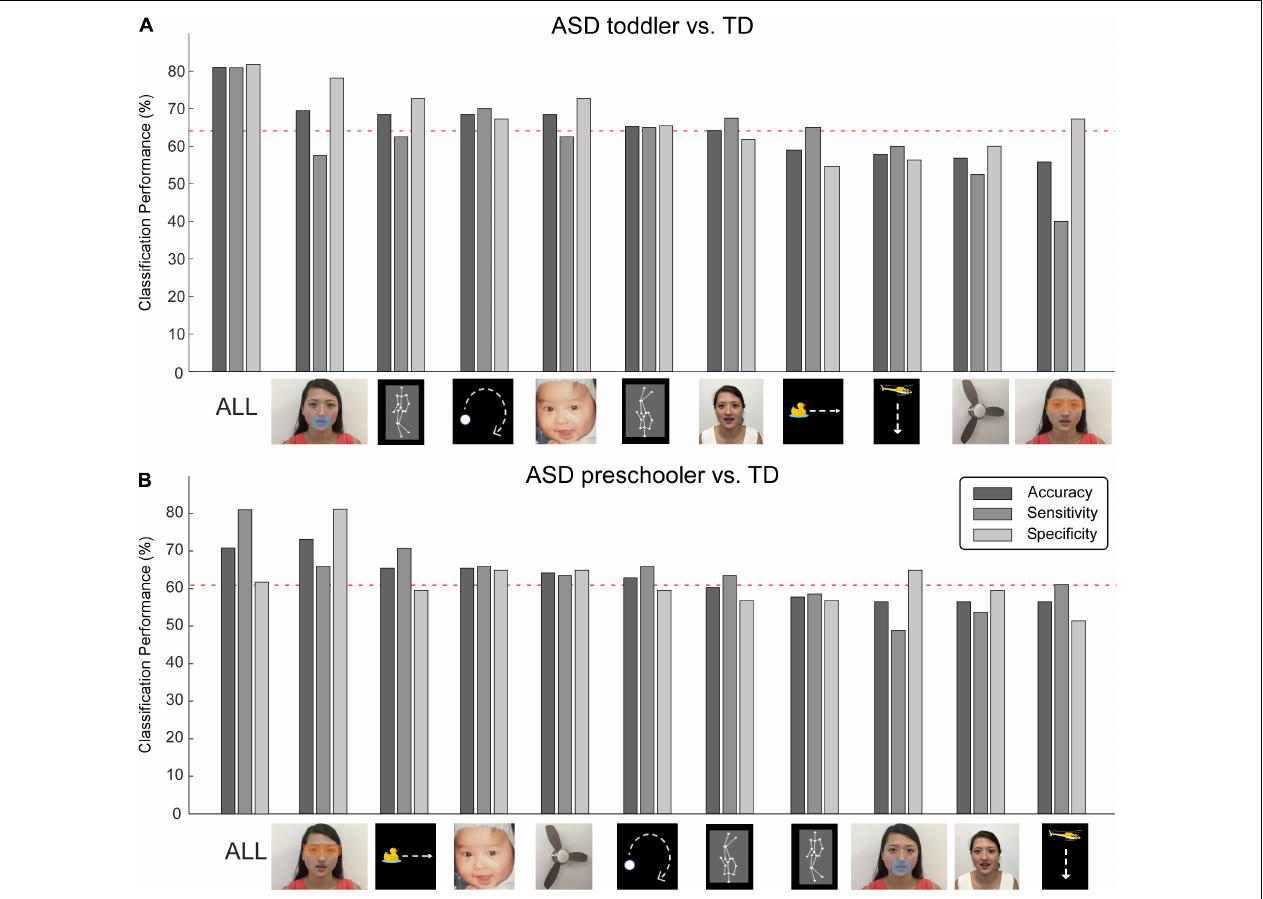
FIGURE 2 | Machine learning accuracies for discriminating autism spectrum disorder (ASD) and typically developing (TD). Classification accuracy, sensitivity, and specificity for all AOIs and 10 single AOIs, for toddlers (A) and preschoolers (B) , respectively. Red dashed lines represent the 95% confidence interval obtained from non-parametric permutation